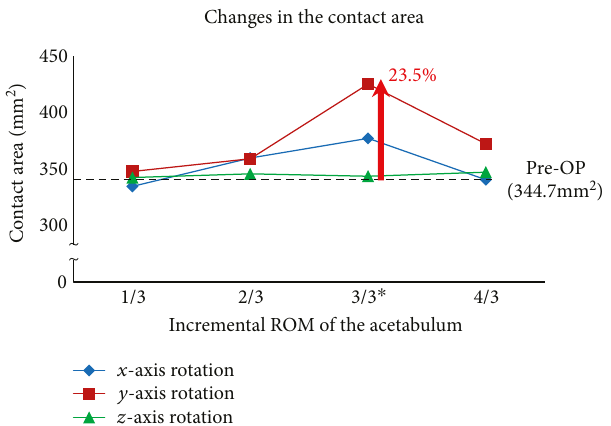
Figure 7: Changes in the contact pressure (95th percentile value) as a function of incremental increased rotations of the acetabulum as compared to the Pre-OP condition. The “ ∗ ” sign indicates the actual acetabular rotation (ACR) during the